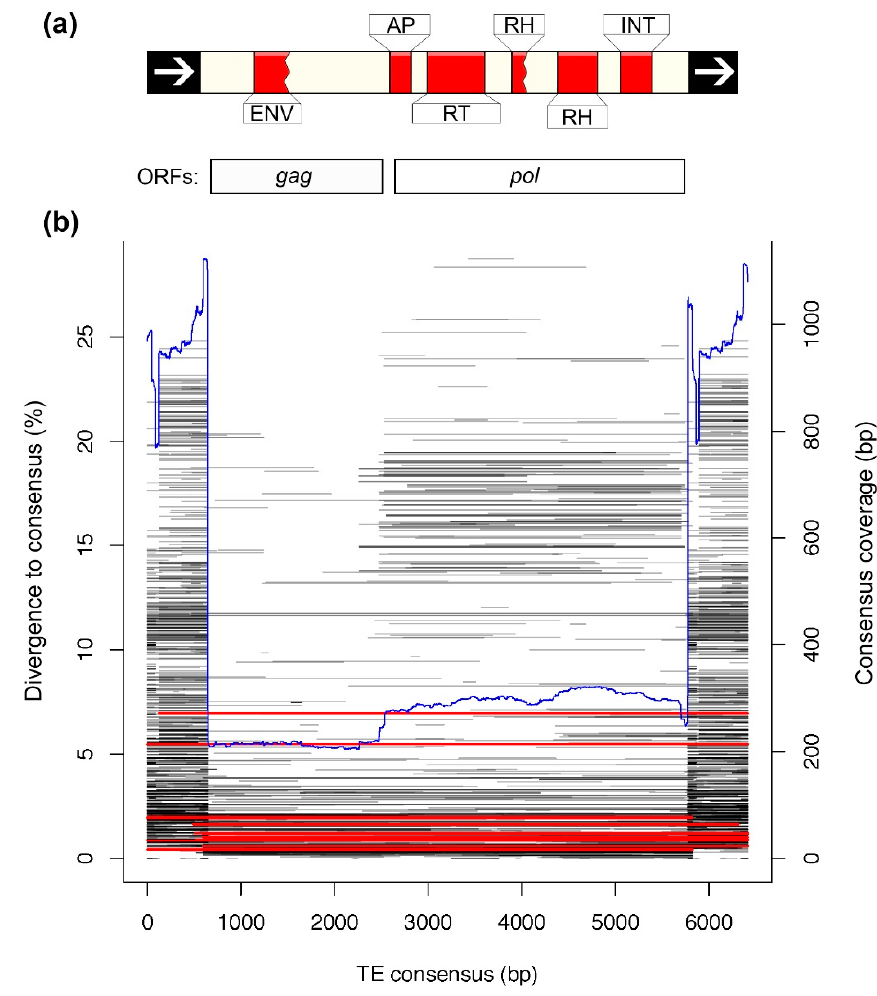
Figure 5. Functional domain annotation and genomic BLASTn hits of TguERVL2_I_Ucy. We predicted conserved domains and open reading frames (ORFs) of the consensus sequence of TguERVL2_I_Ucy ( a ). In addition to the canonical domains (AP, RT, two RH (one partial and one complete), and INT), a disrupted ENV domain was predicted at an upstream position. Panel ( b ) shows the distribution of copies of a pseudo full-length ERV consensus sequence (same LTR flanked by separately classified internal portion) of the TE subfamily TguERVL2_I_Ucy in blue-capped cordon bleu. Most copies in the genome are solo-LTRs and a majority of the full-length copies are less than 5% diverged from the consensus sequence. Hits spanning a majority of the consensus are shown in red and partial hits are black. Blue line represents consensus coverage.